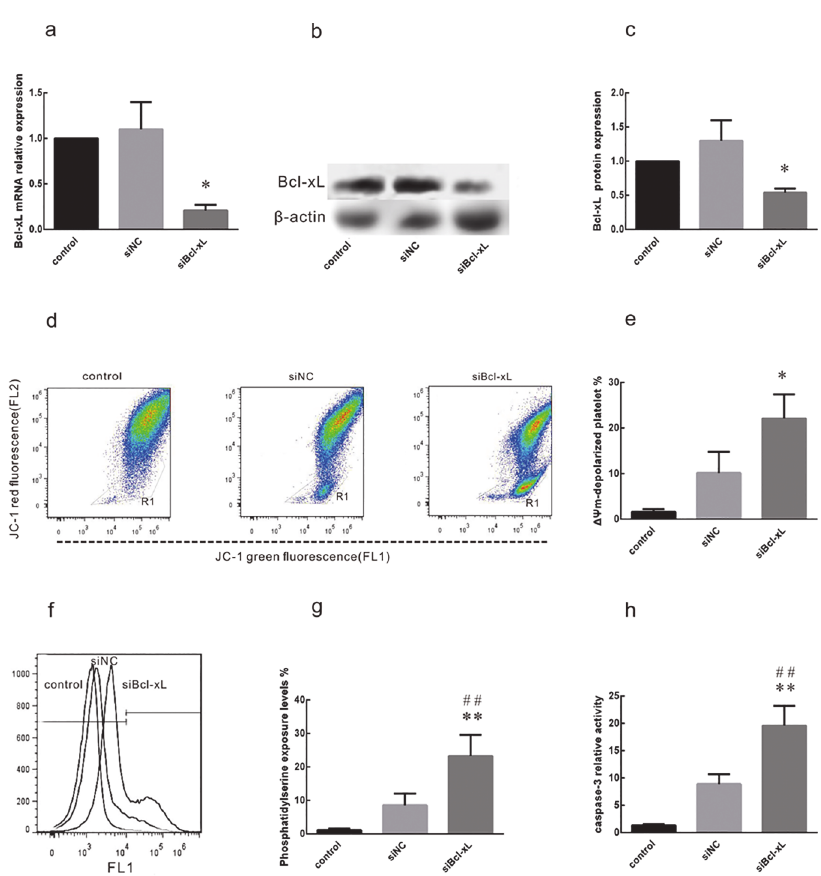
Fig 3. Bcl-xL siRNA effectively knocks down Bcl-xL mRNA and protein and induces platelet apoptosis. Leukocyte-depleted apheresis platelets (LDPs) were transfected with siBcl-xL or negative control siRNA (siNC) at a final concentration of 50 nM. LDPs without transfection were used as blank controls (control). Bcl-xL expression and apoptosis were assessed 48 h after transfection. ( a ) Expression levels of the Bcl-xL mRNA were assessed by qRT-PCR. 5s rRNA was used as an endogenous control. * P < 0.05. ( b,c ) Bcl-xL protein levels were assessed by western blotting. β -actin was used as a loading control. * P < 0.05. ( d, e ) Depolarization of platelet Δ Ψ m was determined by JC-1 fluorochrome staining and flow cytometry. Histograms of platelets with JC-1 staining are shown for mock treated platelets (control) and platelets transfected with siNC or siBcl-xL. Depolarization is characterized as the decrease in the content of JC-1 aggregates, as reflected in the decrease of red (FL2) fluorescence. Dots inside R1 indicate that platelets are out of the main population and are considered to be undergoing Δ Ψ m depolarization. * P < 0.05. ( f, g) Annexin V-FITC staining (R2) demonstrated that the annexin V positive cells in LDPs significantly increased as compared to the mock-transfected control and siNC ( ** P < 0.01 vs. control, ## P < 0.01 vs. siNC). ( h ) The caspase-3 activity in LDPs was significantly increased as compared to control and negative siRNA ( ** P < 0.01 vs. control, ## P < 0.01 vs. siNC). Values are expressed as the mean ± SD; n = 3 in each